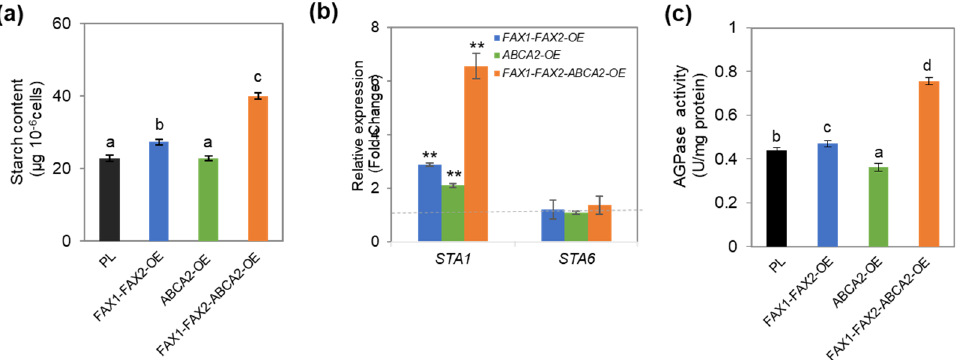
Figure 4. Starch content and expression levels of key genes in starch biosynthesis under TAP − N for 48 h. ( a ) Starch content. ( b ) Transcriptional expression levels of key genes in starch biosynthesis. STA1, the large subunit of ADP − glucose pyrophosphorylase (AGPase); STA6, the small subunit of AGPase. The RT − qPCR results were normalized using the housekeeping gene RACK1 as the internal standard, and the fold changes of the relative expression levels were determined relative to the parental line (PL). Error bars represent standard errors based on four biological replicates. ( c ) The analysis of AGPase activity. Asterisks and distinct letters labelled indicate significant differences by Student’s t test (** p ≤ 0.01) and Tukey’s HSD test, respectively.